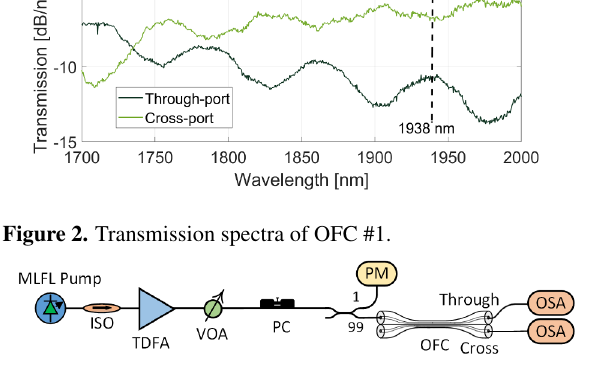
Figure 3. Schematic of the characterization setup. Figure 4a shows the output power of OFC # 1 as a